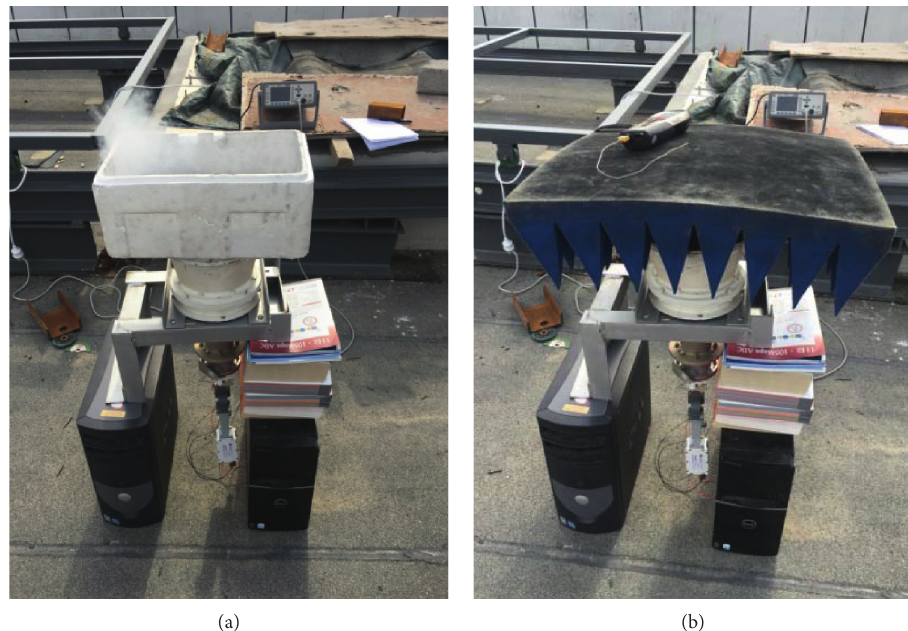
Figure 3: Ku-band receiver of test with the cold and ambient load method.